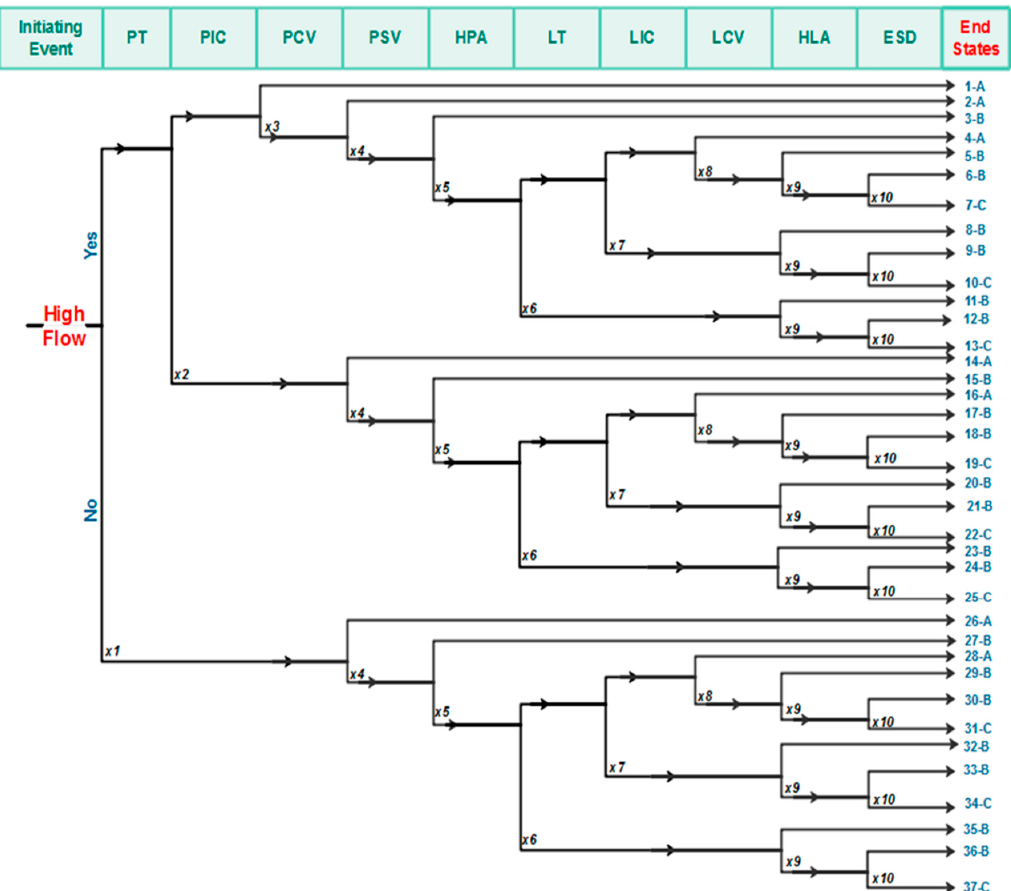
Figure 4. High-pressure (HP) separator 1 event tree model. Reproduced with permission from Niazi et al. [33], Process Safety Progress; published by Wiley, 2020. Table 5 lists the parameters ( (cid:2009) and (cid:2010)) of the beta distribution for different safety systems attached to HP separator 1. Table 5. Beta distribution parameters for different safety systems.